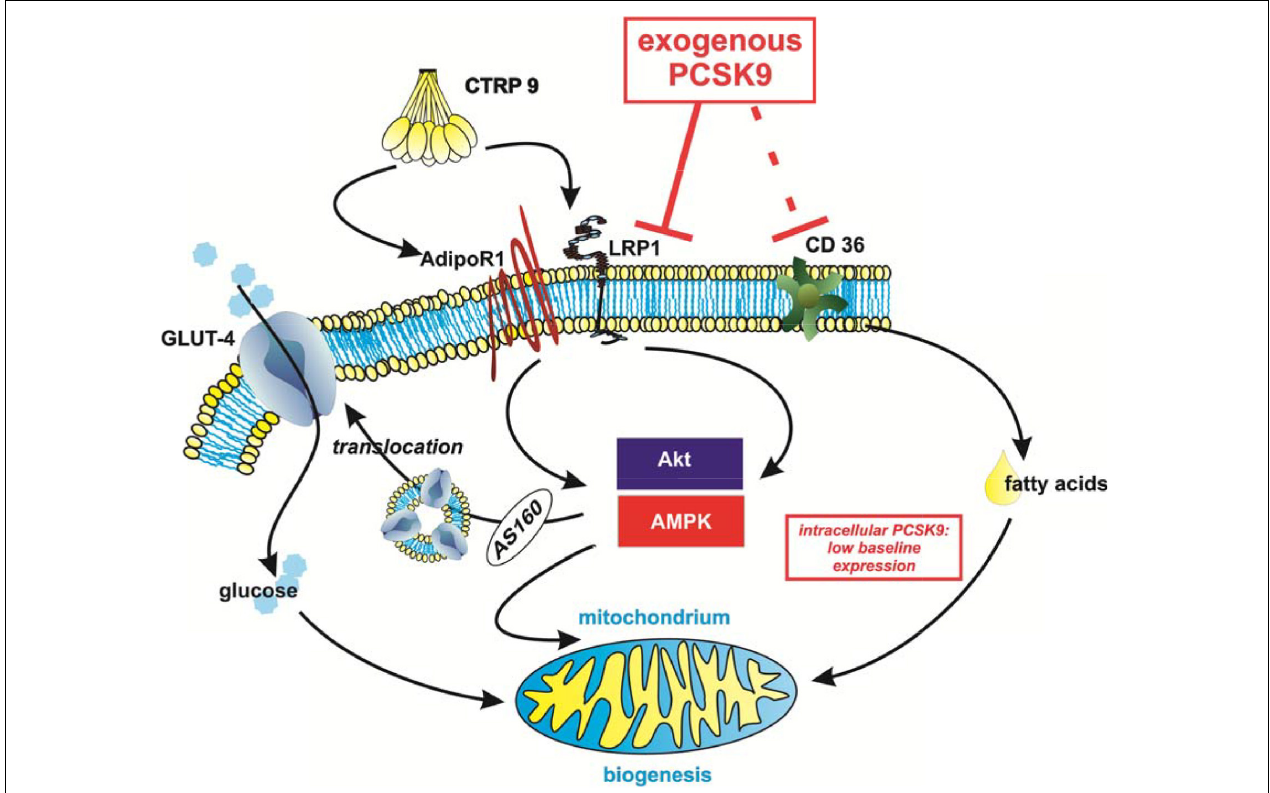
FIGURE 10 | Summary of the potential impact of PCSK9 on cardiomyocyte metabolism. Although endogenous levels of PCSK9 are low in cardiomyocytes, circulating exogenous PCSK9 mediates diverse effects on metabolism via its known targets LRP1 and CD36. This has an impact on Akt- or AMPK-mediated glucose uptake and mitochondrial biogenesis in cardiomyocytes. The effects on fatty acid uptake appear to be at least in part independent from PCSK9-mediated changes in CD36 protein expression and LRP1 in